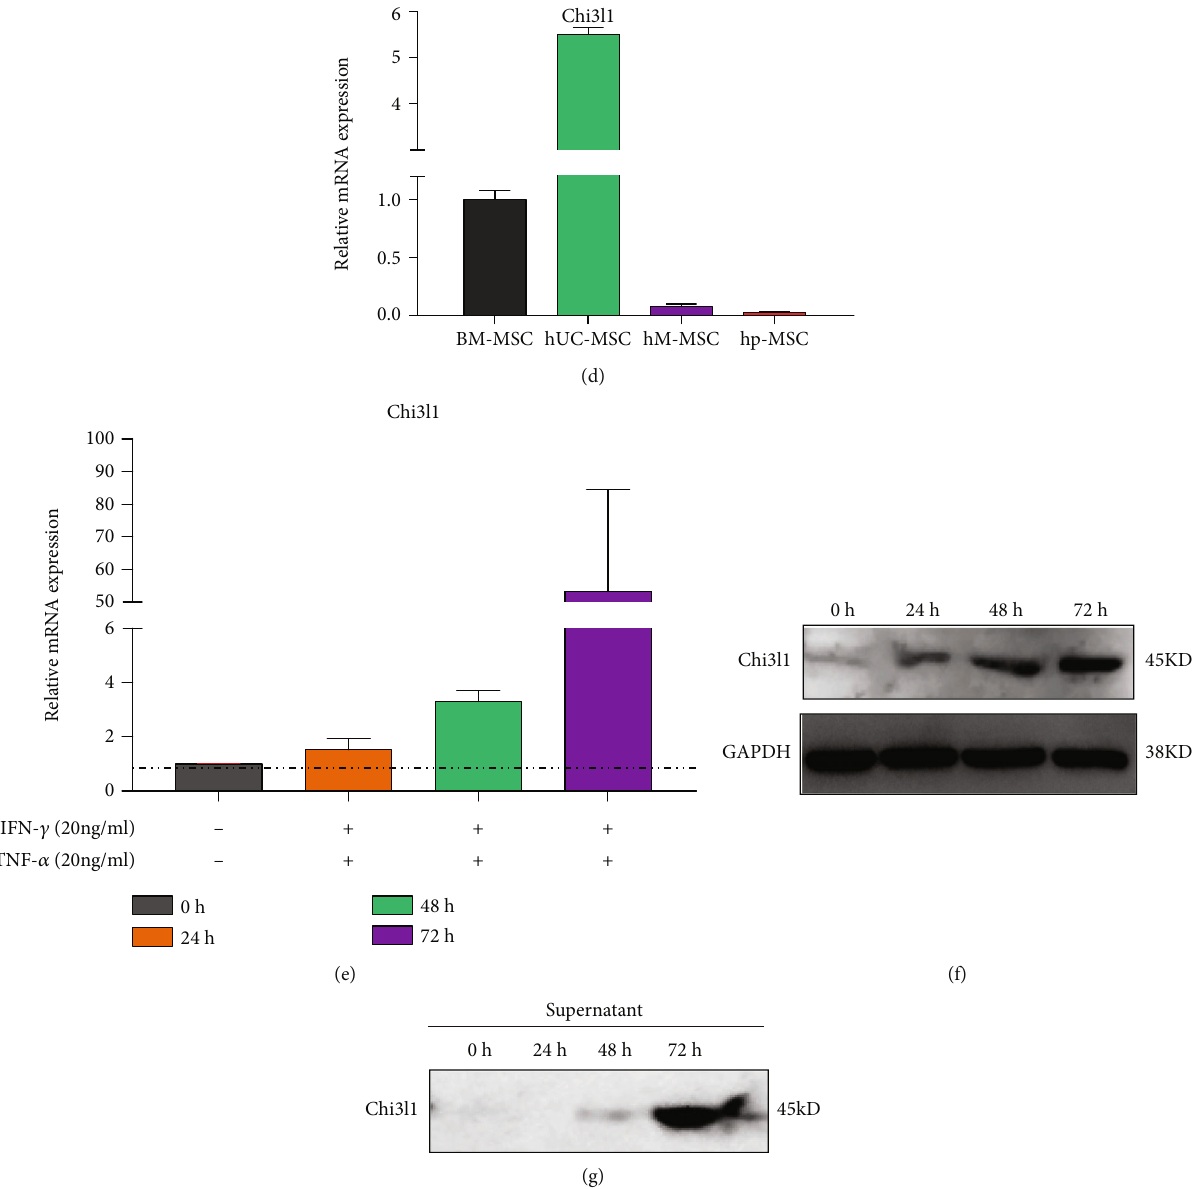
Figure 1: Chi3l1 is highly expressed in hUC-MSCs. (a) Heat map of di ff erential gene expression in various MSCs, including BM-MSCs, hP- MSCs, hM-MSCs, and hUC-MSCs. (b) A volcano plot was used to analyze the DEGs (red indicates upregulated genes). (c) KEGG pathway indicating that Chi3l1 is highly associated with the JAK-STAT signaling pathway and graft-versus-host disease (GvHD) in hUC-MSCs. (d) Chi3l1 expression in di ff erent MSCs by qPCR. (e) hUC-MSCs were treated with IFN- γ and TNF- α (20 ng/ml) for 24h, 48 h, and 72 h, and Chi3l1 mRNA levels were measured by qPCR. (f) The protein expression of Chi3l1 in IFN- γ - and TNF- α -pretreated hUC-MSC supernatants was analyzed by western blot. (g) The Chi3l1 protein expression levels in IFN- γ - and TNF- α -pretreated hUC-MSCs determined by western blot. JAK: Janus kinase; STAT: signal transducer and activator of transcription; IFN- γ : interferon-gamma; TNF- α : tumor necrosis